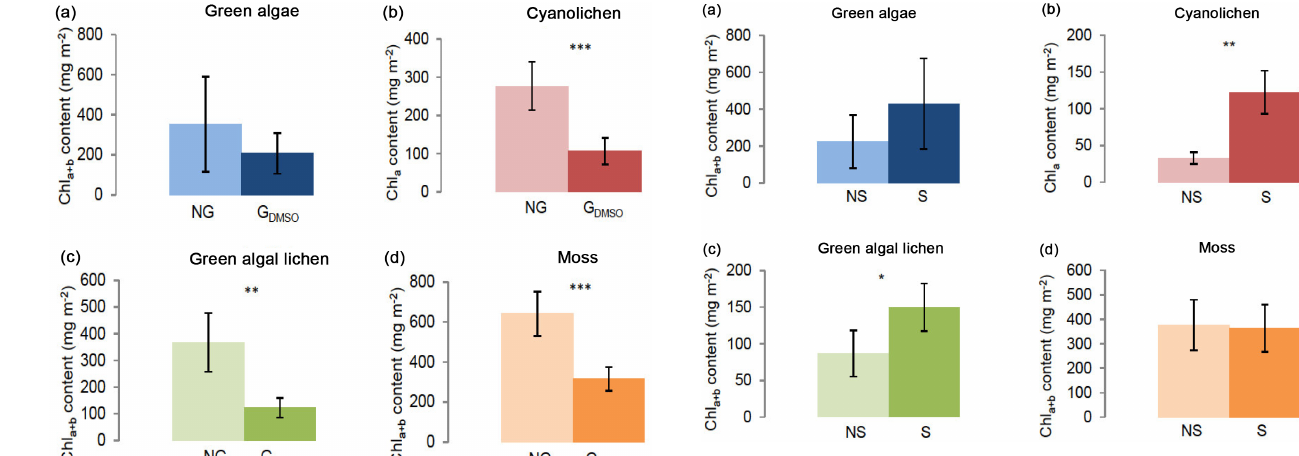
Figure 4. Chlorophyll a + b /chlorophyll a content (mgm − 2 ) de- pending on intermediate shaking (S) after each extraction cycle as compared to control extractions without shaking (NS). Inves- tigation of green algae- (a) , cyanolichen- (b) , green algal lichen- (c) , and moss-dominated biocrusts (d) using the DMSO extrac- tion method. To prove statistical differences between shaking (S) and non-shaking (NS) a Welch test was performed for cyanolichen- dominated biocrusts (data without homogeneity of variance). For all other biocrust types an unpaired t test was carried out. ( ∗ p ≤ 0 . 05; ∗∗ p ≤ 0 . 01; ∗∗∗ p ≤ 0 .